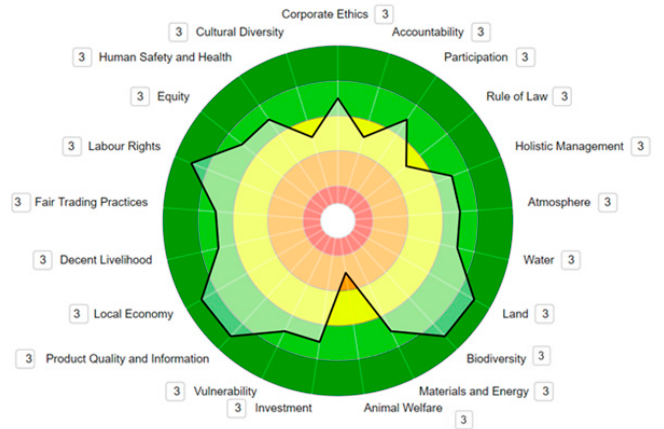
Figure 10. SAFA assessment result of the start-up as spider graph. The number near indicators suggest the data quality according to Table 4, and also, the colour in the circles represent the range score. As reported in Table 3, the colour means the performance score: Dark green: Best; light green: Good; yellow: Moderate; orange: Limited; red: Unacceptable. The organic management and involvement of local stake-holders generate high level of sustainability, with several green scores.